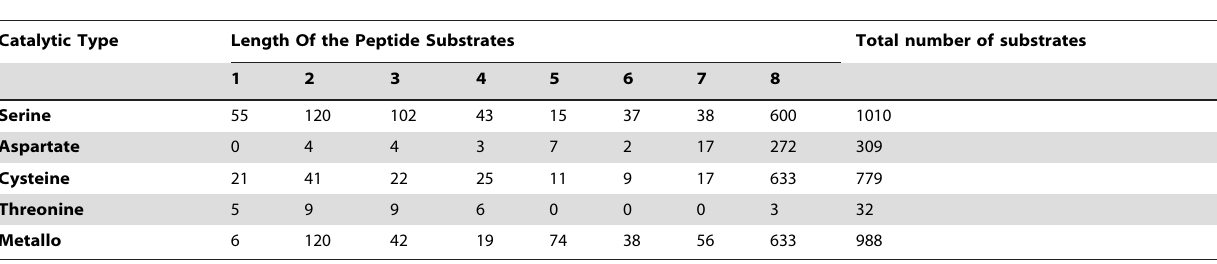
Table 1. Summary of the number and type of peptide substrates in MEROPS database.